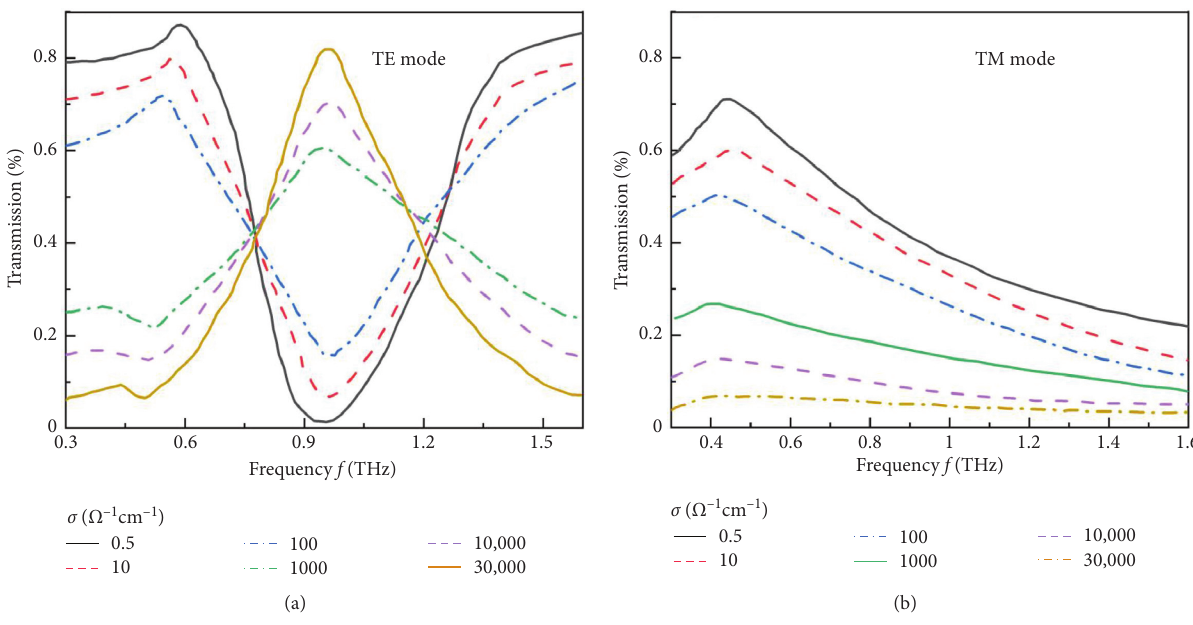
Figure 3: Transmission spectra of the device for different electronic conductivities under (a) TE mode and (b) TM mode.